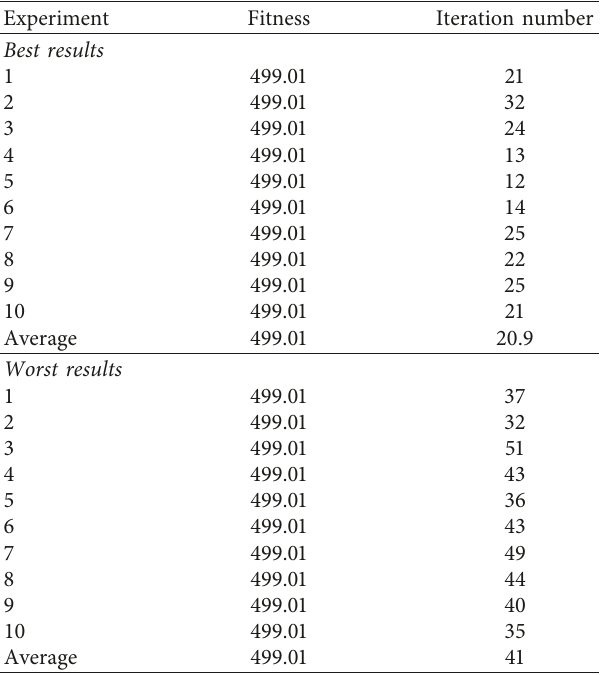
Table 1: QGFA optimization results for Shekel’s Foxholes.